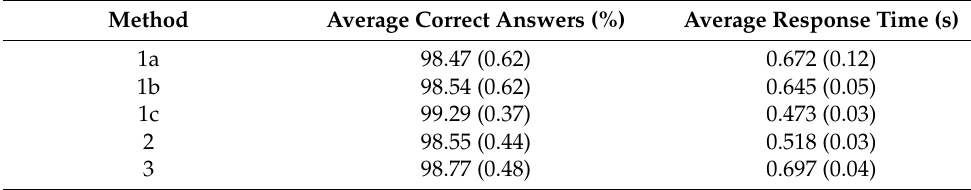
Table 2. Mean (standard error) behavioral accuracy and response time for each